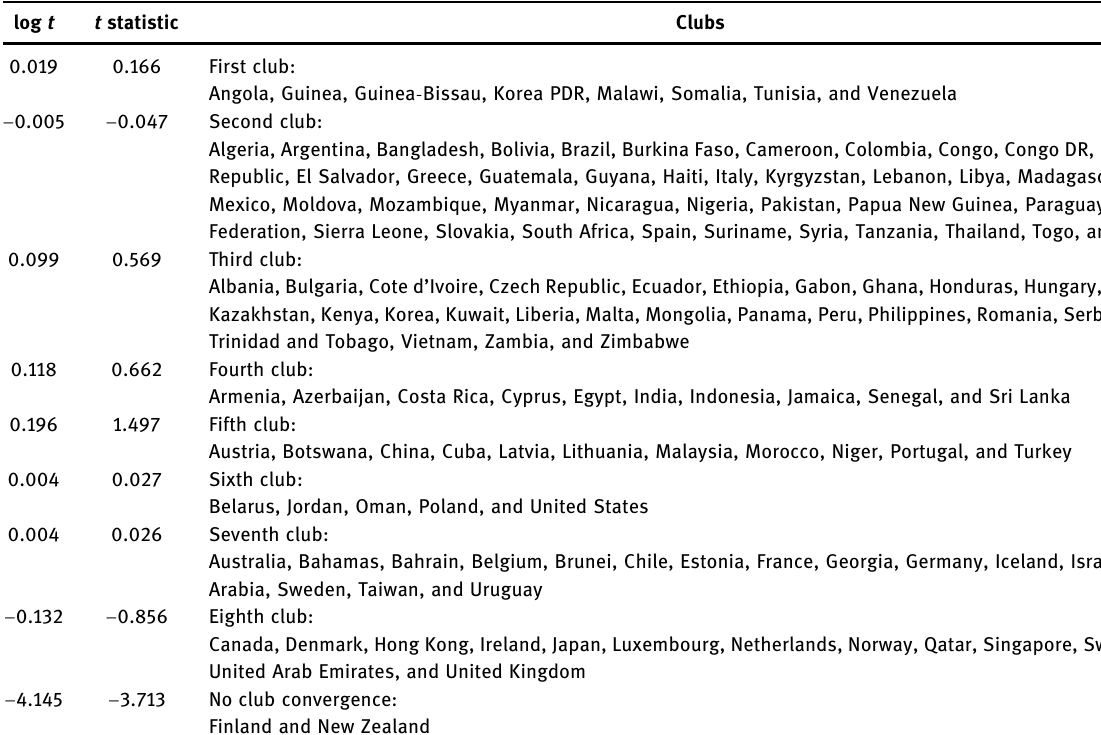
Table 3: Cluster convergence analysis ( 1984 – 2017 )